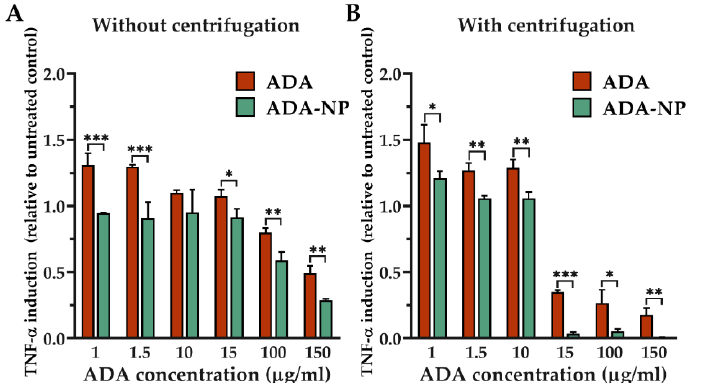
Figure 5. Tumor necrosis factor α (TNF- α ) levels in the supernatant of J774.A1 macrophages pre- treated with 10 µg/mL LPS and incubated overnight with different concentrations of free or particle- bound ADA ( A ) without or ( B ) with 15-min-long centrifugation at 21,000 × g . The results have been expressed as fold relative to the untreated control. Data are shown as mean ± SD ( n = 3). Statistical significance was assessed by unpaired t -test (* p < 0.05, ** p < 0.01, *** p < 0.001). ADA, adalimumab; ADA-NP, ADA conjugated nanoparticles; LPS, lipopolysaccharide.